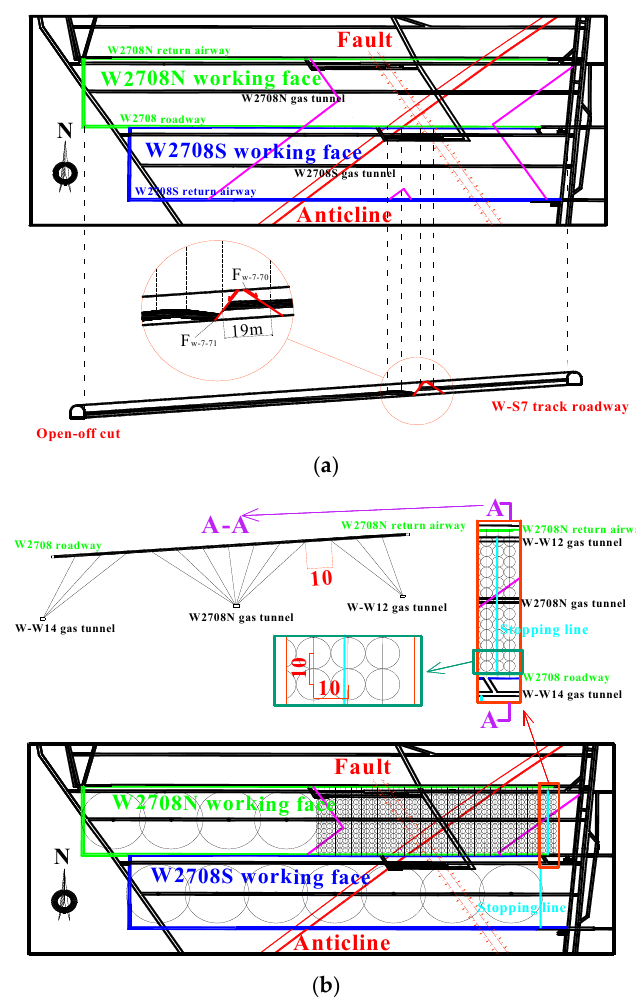
Figure 5. Diagram of the working face design: ( a ) Diagram of the working faces, roadways, and geological structure; ( b ) Diagram of the fracturing boreholes and slotting boreholes.